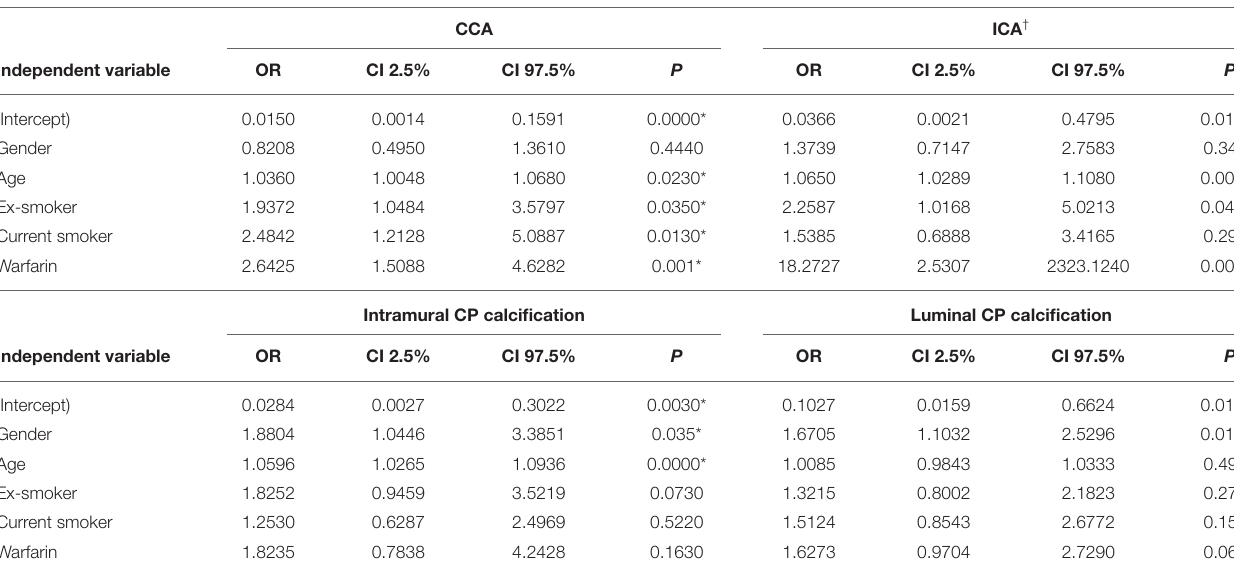
TABLE 2 | Results of the multivariable logistic regression model for radiological calcification (upper) and macroscopic calcification (lower). CCA ICA † Independent